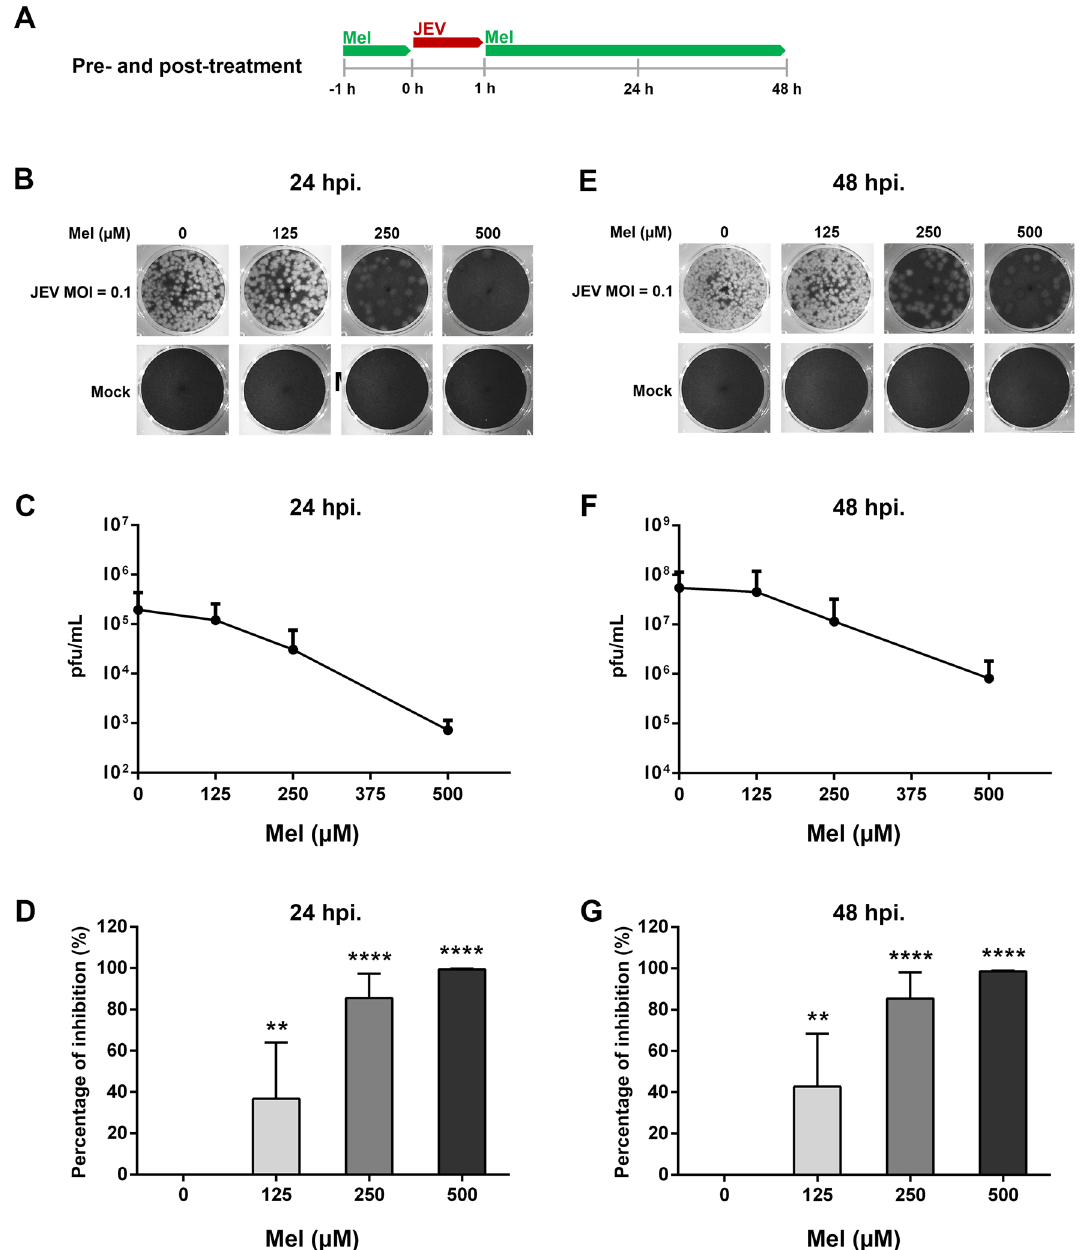
Figure 3. Antiviral effect of melatonin (Mel) on Japanese encephalitis virus (JEV)-infected SH-SY5Y cells in a pre- and post-infection treatment assay. ( A ) Schematic representation of the experimental design. The red line indicates the JEV absorption period and green line indicates the period when the cells were incubated with melatonin. SH-SY5Y cells were pre-treated with melatonin at various concentrations prior to infection with JEV at 0.1 MOI and then maintained in melatonin for 24 and 48 h. ( B , E ) Representative plaque formation assay results. Mock is uninfected cells treated with melatonin. ( C , F ) The viral titers in pfu/ml determined by plaque assay from cell culture supernatant, and ( D , G ) the reduction of viral titers expressed as percentage of inhibition. The graphs show the means ± SD of three independent experiments in technical triplicates. One-way ANOVA and Tukey–Kramer multiple comparisons tests were performed for statistical analysis. ** p < 0.01 and **** p < 0.0001 compared to the control without melatonin treatment (0